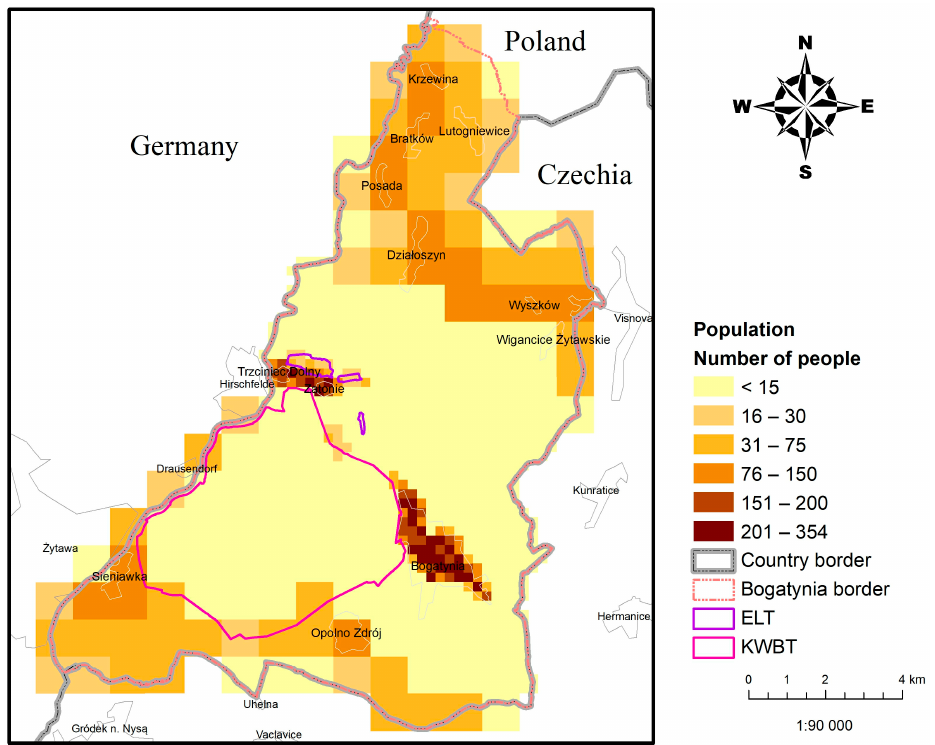
Figure 6. Map of the population density distribution ( source: own study).